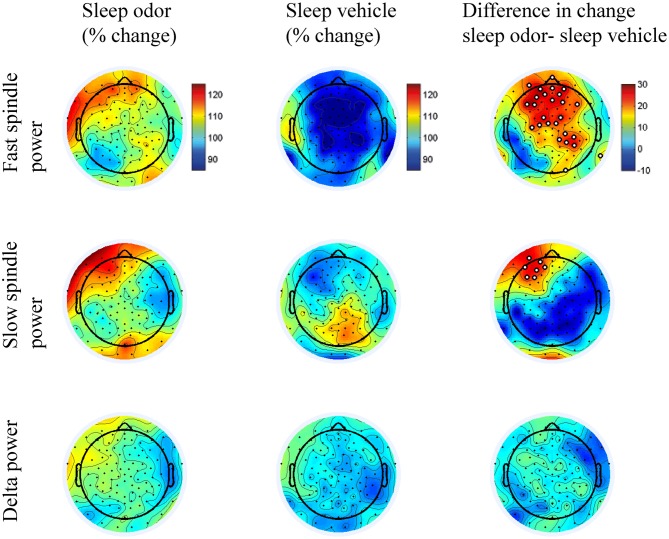
Scalp distributions of the sleep odor and sleep vehicle groups. Figures illustrate the scalp distributions in the fast (13.00–15 Hz) and slow (11.0–13.0 Hz) spindle bands and in the delta band (1.5–4.5 Hz). Data is indicated for the percentage change from the 10-s off interval to the 10-s on interval for the sleep with odor re-presentation and the sleep with vehicle presentation groups. The last column illustrates the difference in scalp distributions between the two groups. We conducted a t test for each electrode site between the two groups and marked electrodes in white in the difference plots if the p value was < 0.05.